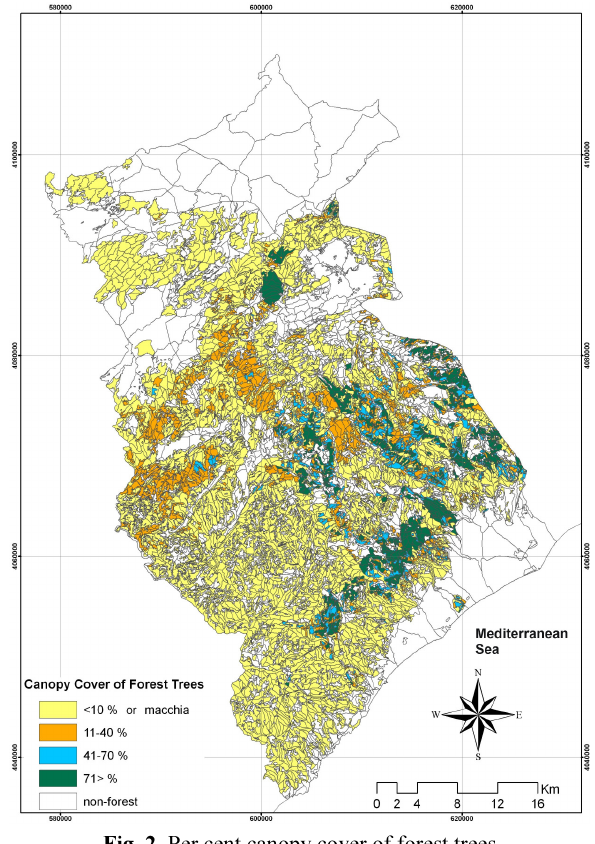
Fig. 2. Per cent canopy cover of forest